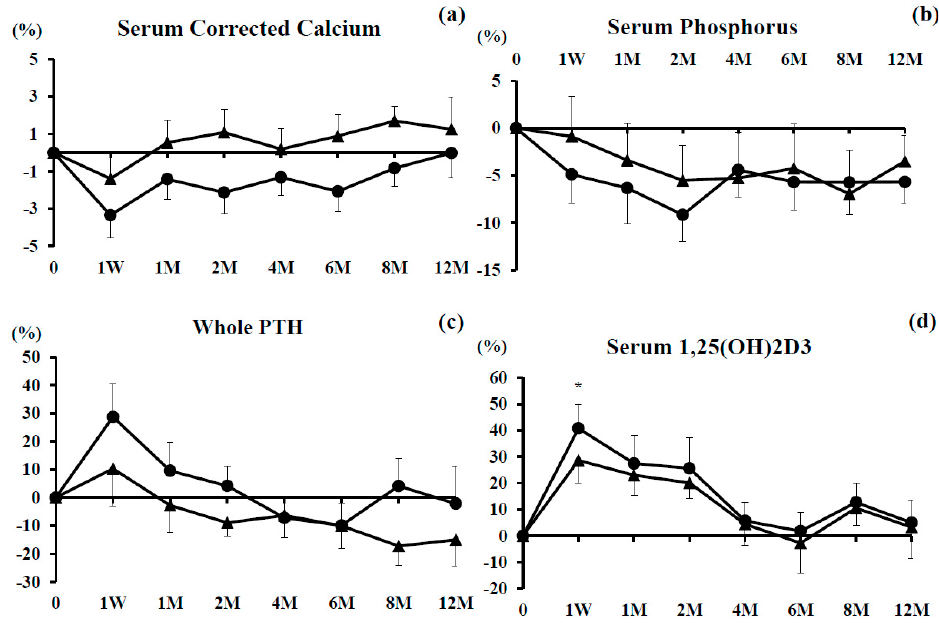
Figure 1. Percent changes of serum calcium ( a ); serum phosphorus ( b ); serum whole parathyroid hormone (PTH) ( c ); serum 1,25(OH) 2 D 3 ( d ) over the 12-month study period. Closed circles show the denosumab monotherapy group and closed triangles show the combination group. Single asterisk (*) denotes significant differences ( p < 0.05) at each time point compared with pretreatment in denosumab monotherapy.